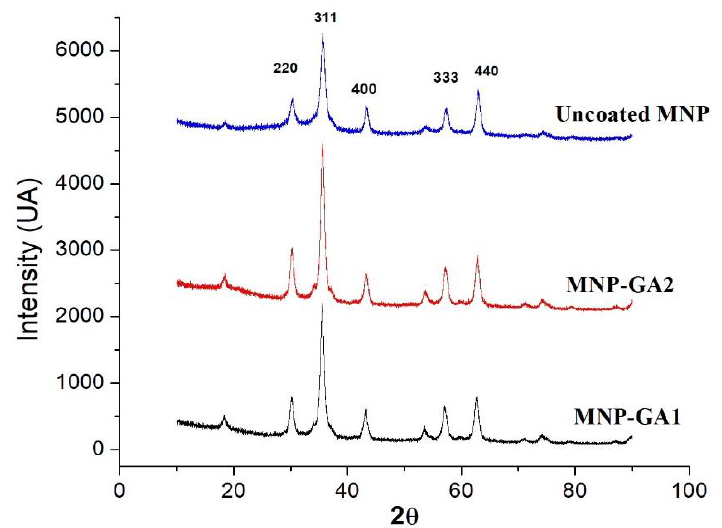
Figure 1. XRD patterns of the hybrid magnetic nanoparticles: MNP-GA1 (dark line), MNP-GA2 (red line) and uncoated MNPs (blue line).